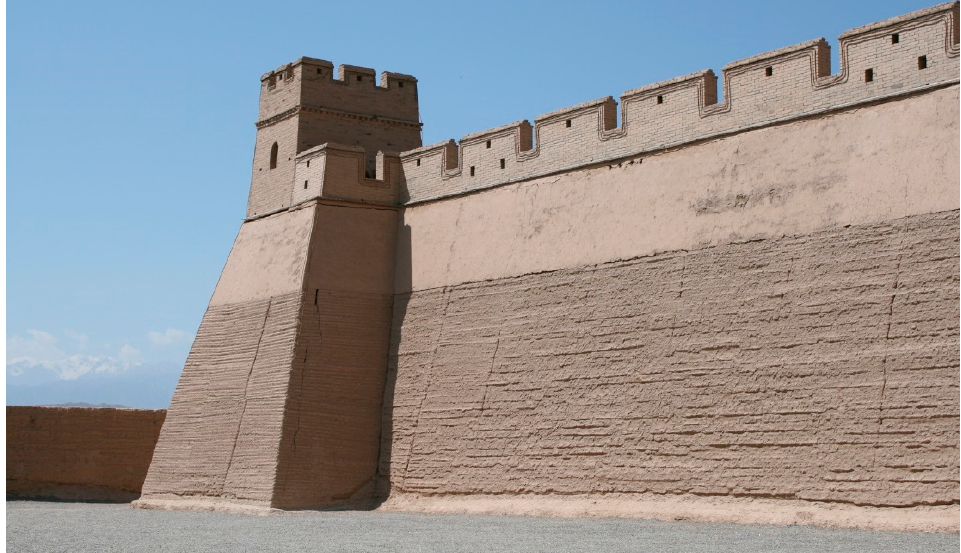
Figure 2. The Great Wall of China erected with rammed earth technology.